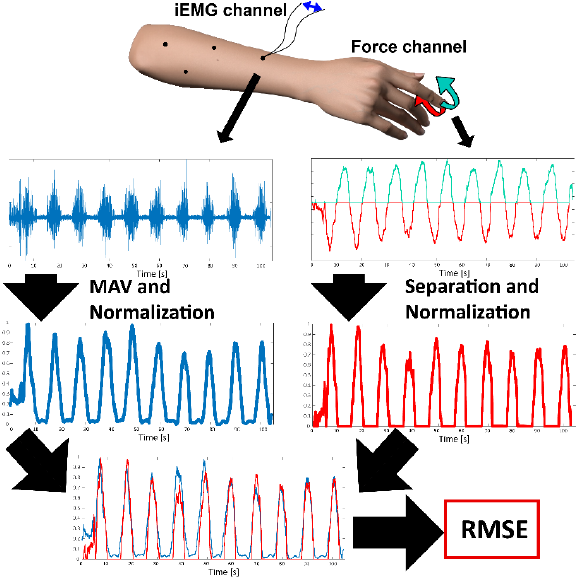
Figure 2. Schematic representation of the signal pre-processing and testing of algorithms steps. For each iEMG channel (left side, blue signals), the MAV feature was extracted. In the following step, the MAV features were normalized for each movement based on only two first sine tracking periods (out of 10 repetitions). Hand and wrist forces (right side) were divided into positive (teal) and negative phases (red signals), after which individual phases were normalized (0–1) for each movement. To establish a correlation between iEMG channels (differential wires) and the phases of the force channels, a systematic evaluation of RMSE metrics between normalized MAV features and forces was conducted. The result of this process was a lookup table connecting iEMG channel, force channel (gauge), force phase, and movement (see the file “Fine-wire force-emg pairs” provided in the database paper [24]). The example signals are based on subject 4’s FPL muscle and thumb flexion/extension.